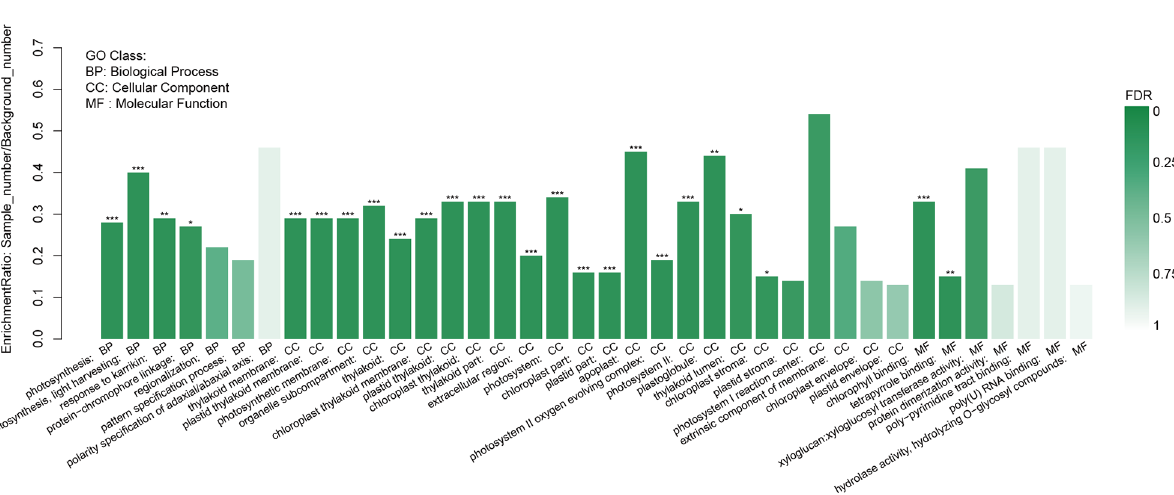
Fig 7. Histogram of GO enrichment distribution of differentially expressed genes (DEG). FDR < 0.001was marked (cid:3)(cid:3)(cid:3) , FDR < 0.01 was marked (cid:3)(cid:3) , FDR < 0.05 was marked (cid:3) .